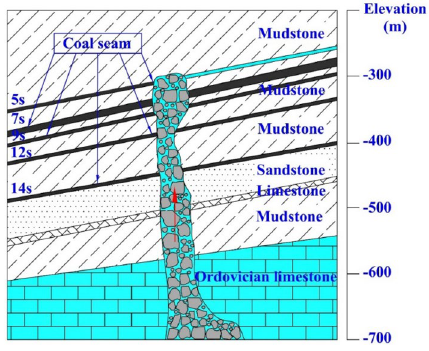
Figure 5. The location and spatial distribution of the Karst collapse